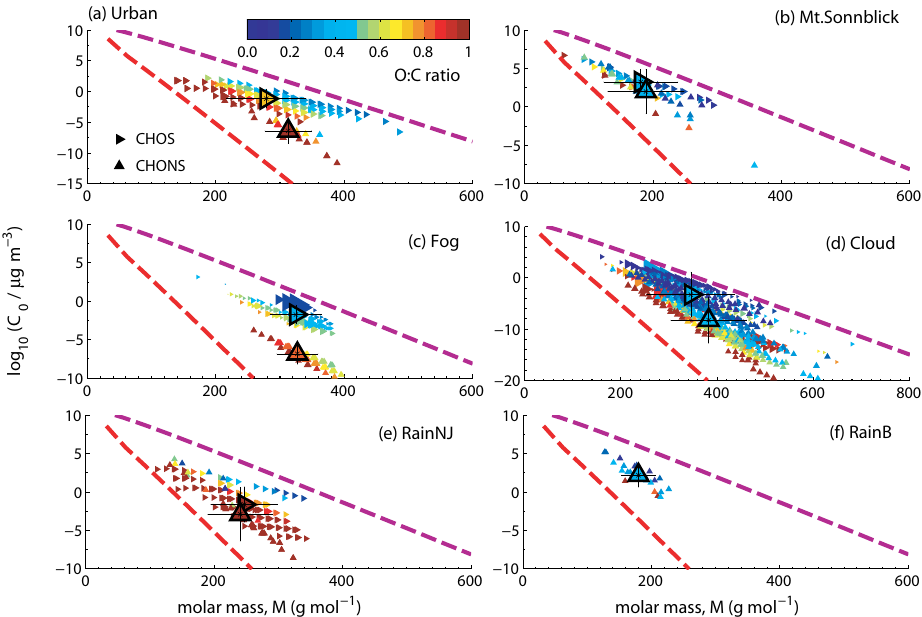
Figure 7. Molecular corridors of saturation mass concentration ( C 0 ) vs. molar mass ( M) for S-containing compounds collected from (a) ur- ban areas including Shanghai (Ma et al., 2014; Tao et al., 2014) and Guangzhou (Lin et al., 2012), Taipei (Lin et al., 2012), Lahore (Stone et al., 2012), Bakersfield (O’Brien et al., 2014) and Los Angeles (Tao et al., 2014), (b) Mt. Sonnblick (Holzinger et al., 2010), (c) fog in Fresno (Mazzoleni et al., 2010), (d) cloud at Mt. Werner (Zhao et al., 2013), (e) rain in New Jersey (Altieri et al., 2009a, b), and (f) rain in Bermuda (Altieri et al., 2012). The small markers represent individual compounds color-coded by atomic O : C ratio. The size of the small markers in (c) and (d) is linearly scaled by relative intensity of MS signal. The larger symbols with error bars indicate the surrogate compounds with the mean values of M , C 0 , and O : C ratio (relative abundance considered for c and d